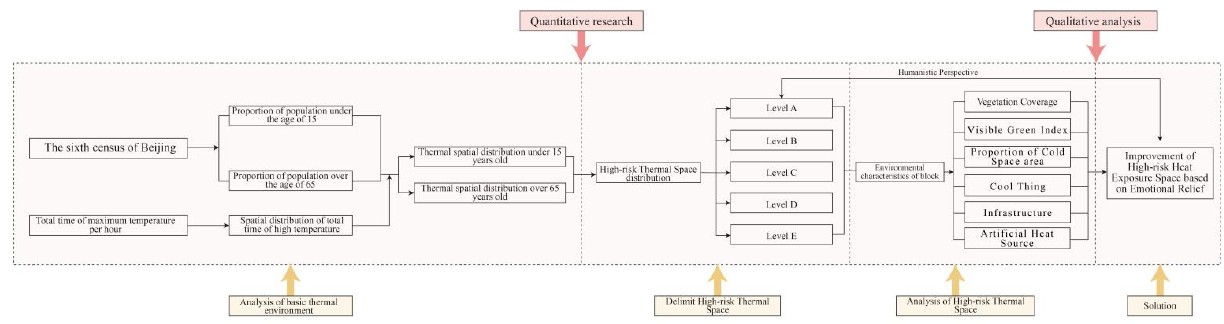
Figure 1. Research process used to investigate high-risk heat exposure spaces in the central urban area of Beijing from a humanistic perspective.